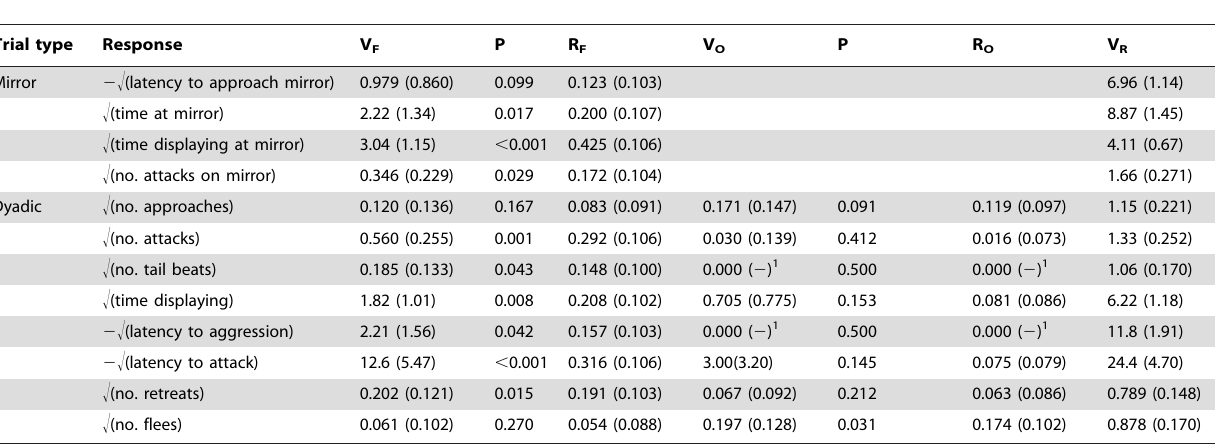
Table 1. Estimated variance components (with standard errors in parentheses) for behavioural